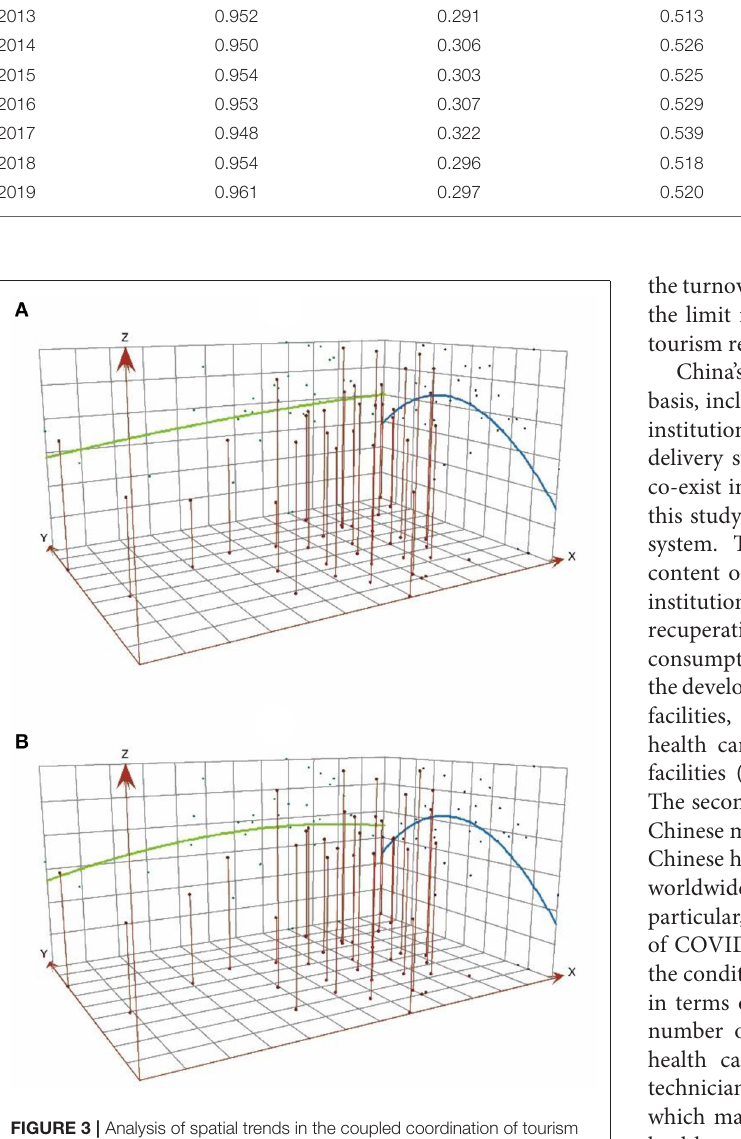
FIGURE 3 | Analysis of spatial trends in the coupled coordination of tourism development and medical services (A) 2012, (B)